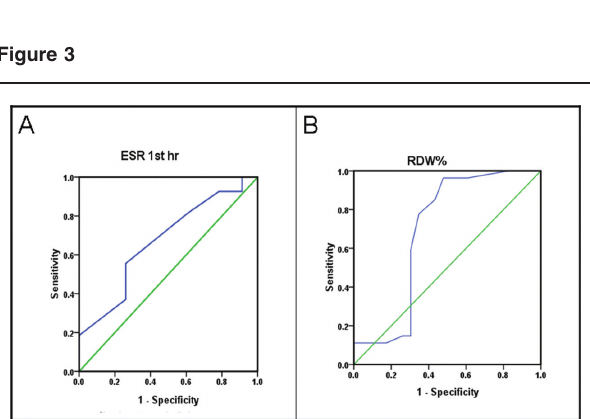
ROC curve of optimal cut-off level of ESR 1 st hour ( ≥ 35) associated with treatment failure with sensitivity of 55.6% and specificity of 74.9% (figure A). ROC curve of optimal cut-off level of RDW ≥ 15.5% associated with treatment failure with sensitivity of 77.8% and specificity of 65.2%